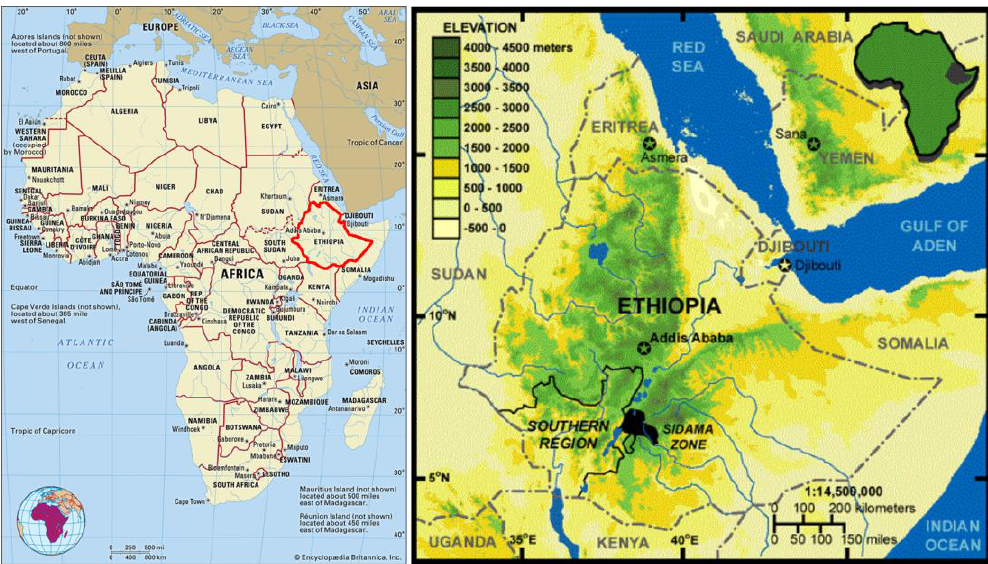
Figure 1. Maps of Africa (on the left) and Ethiopia (on the right).